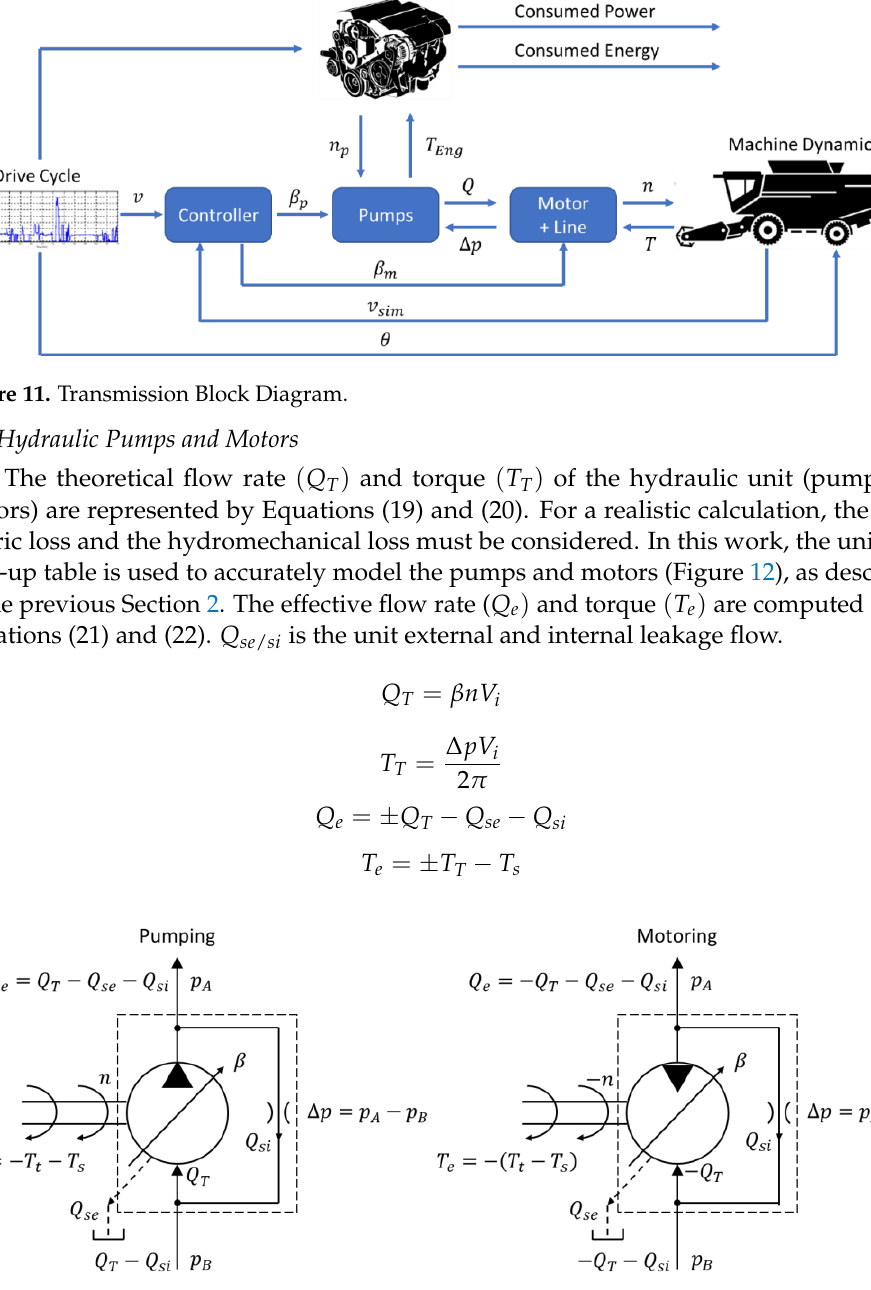
Figure 11. Transmission Block Diagram.